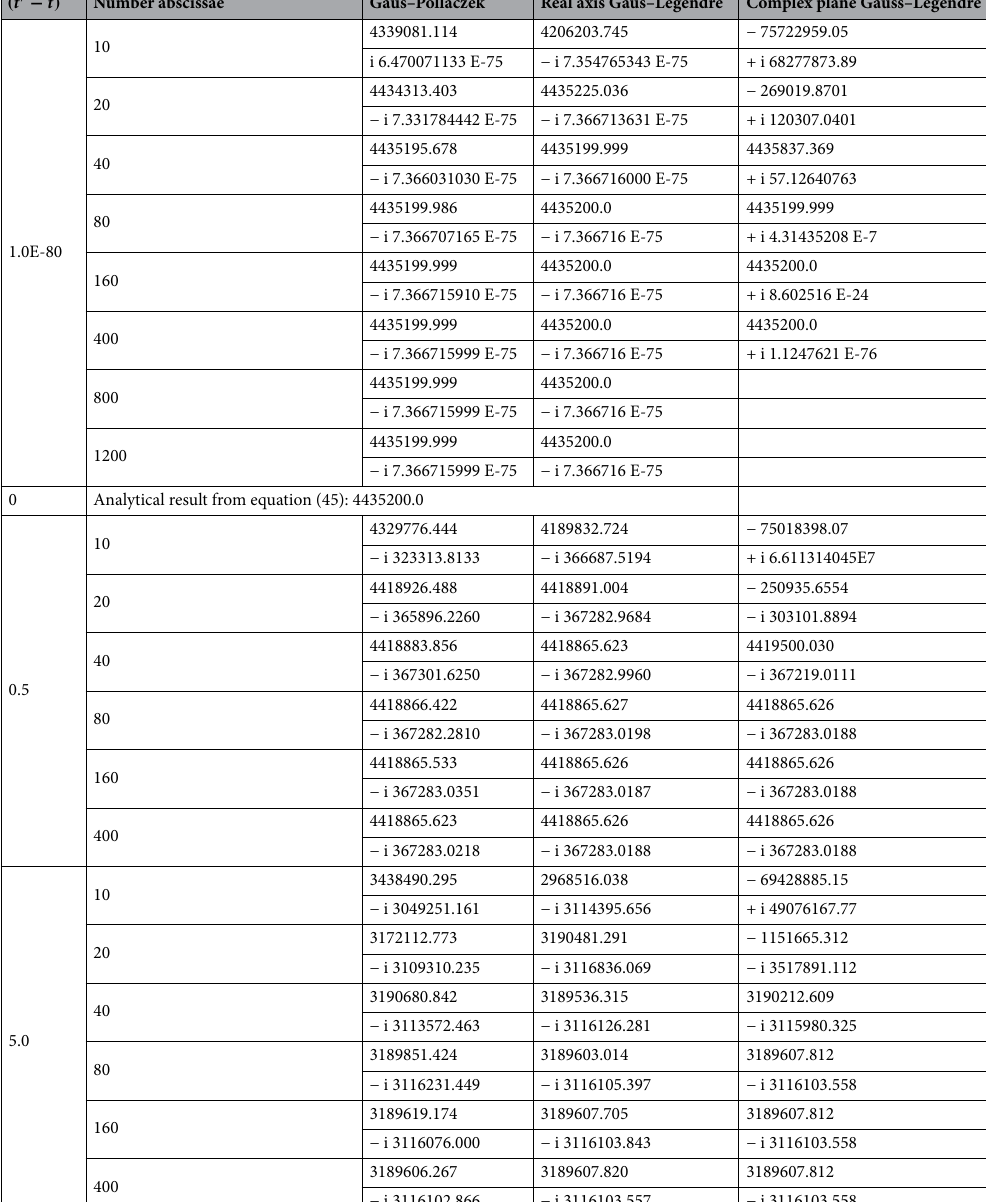
Table 5. Results for angular momentum l = 4 . Same as Table 3 but with l = 4 and ( z = 1, (cid:31) =